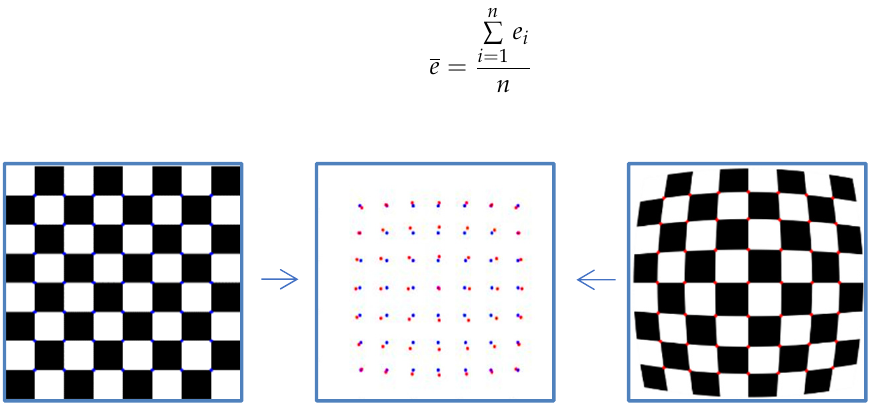
Figure 7. The deviation of the corner points of the distorted checkerboard (red) from the corner points of the standard checkerboard (blue).